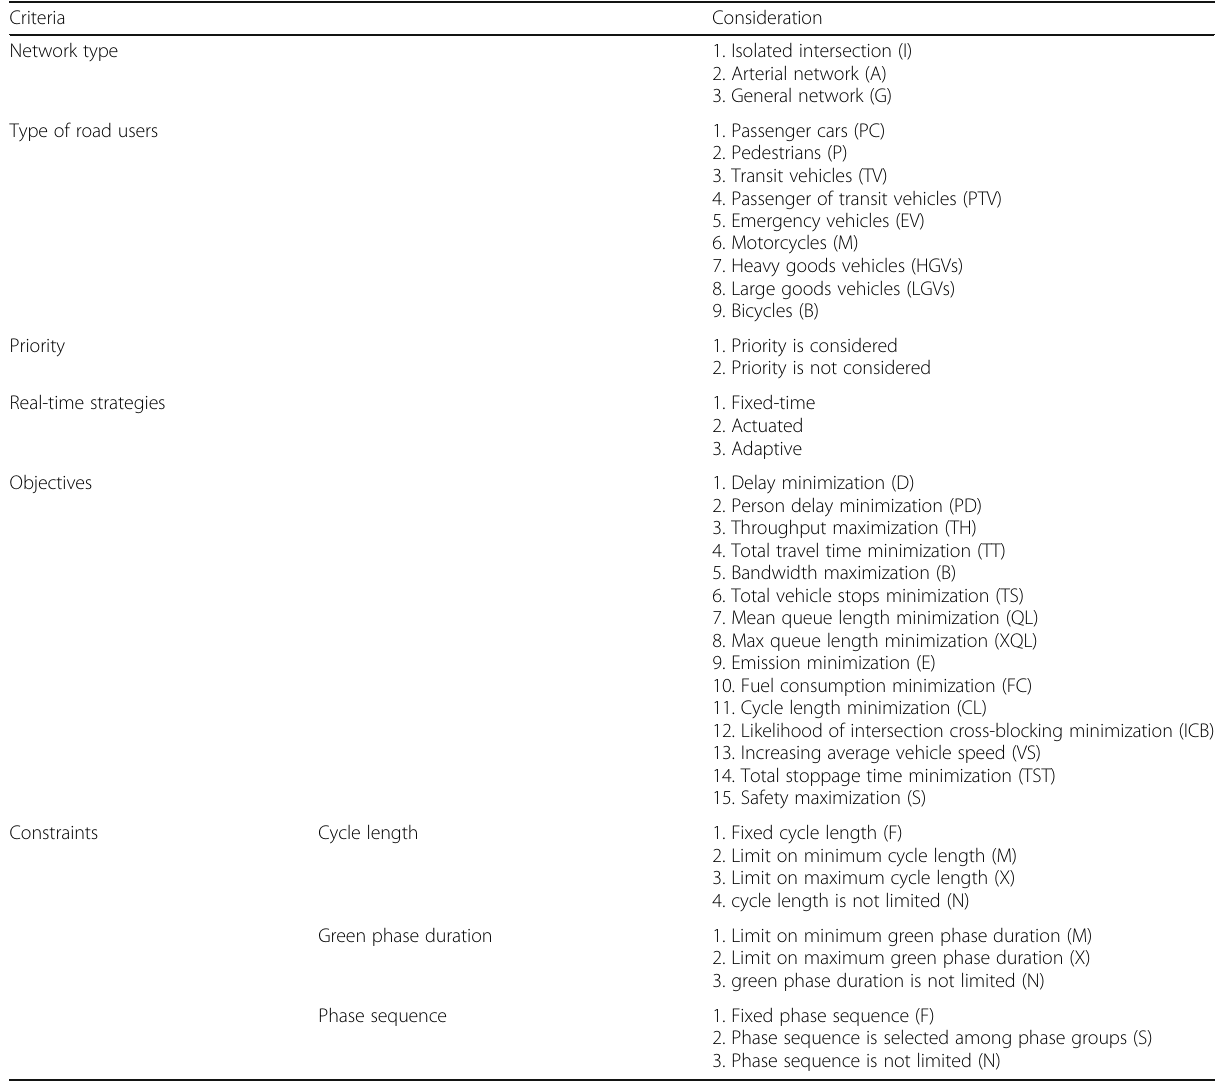
Table 2 ITSCP classification based on problem characteristics